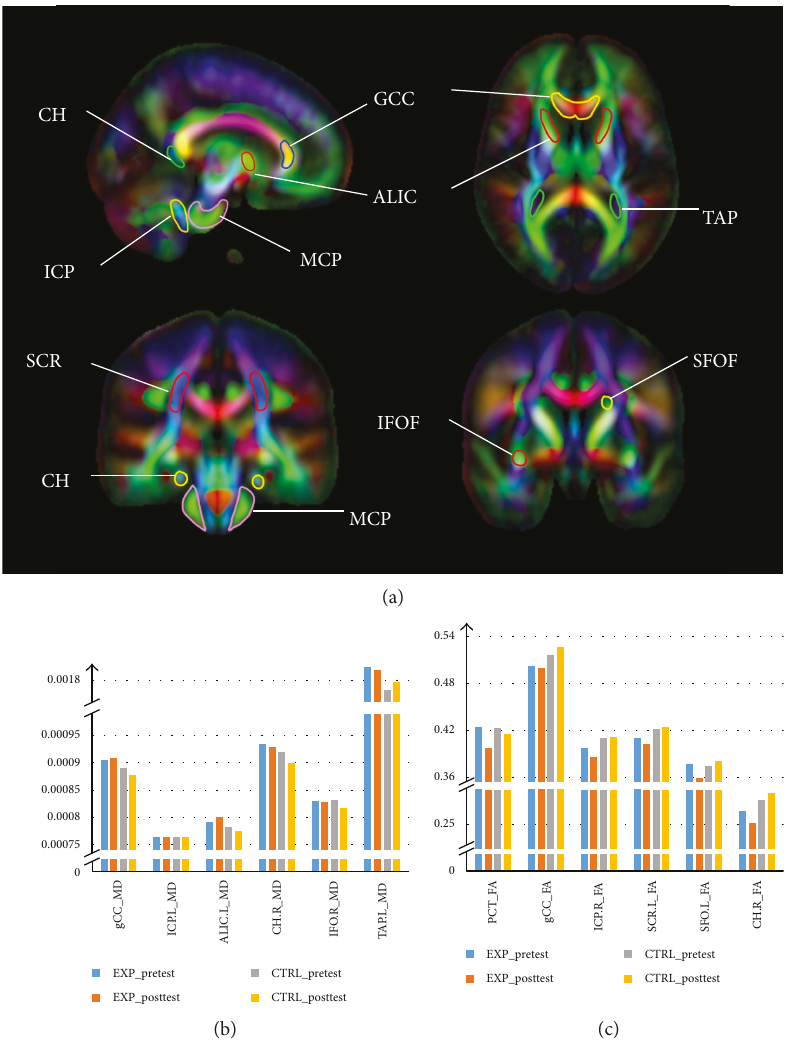
Figure 2: (a) nine anatomical regions de fi ned by the ICBM DTI-81 atlas with signi fi cant changes after exercise intervention. Di ff erence in MD (b) and FA (c) values for speci fi c fi ber tracts in an atlas-based ROI analysis between the experimental group (blue, orange) and the control group (gray,